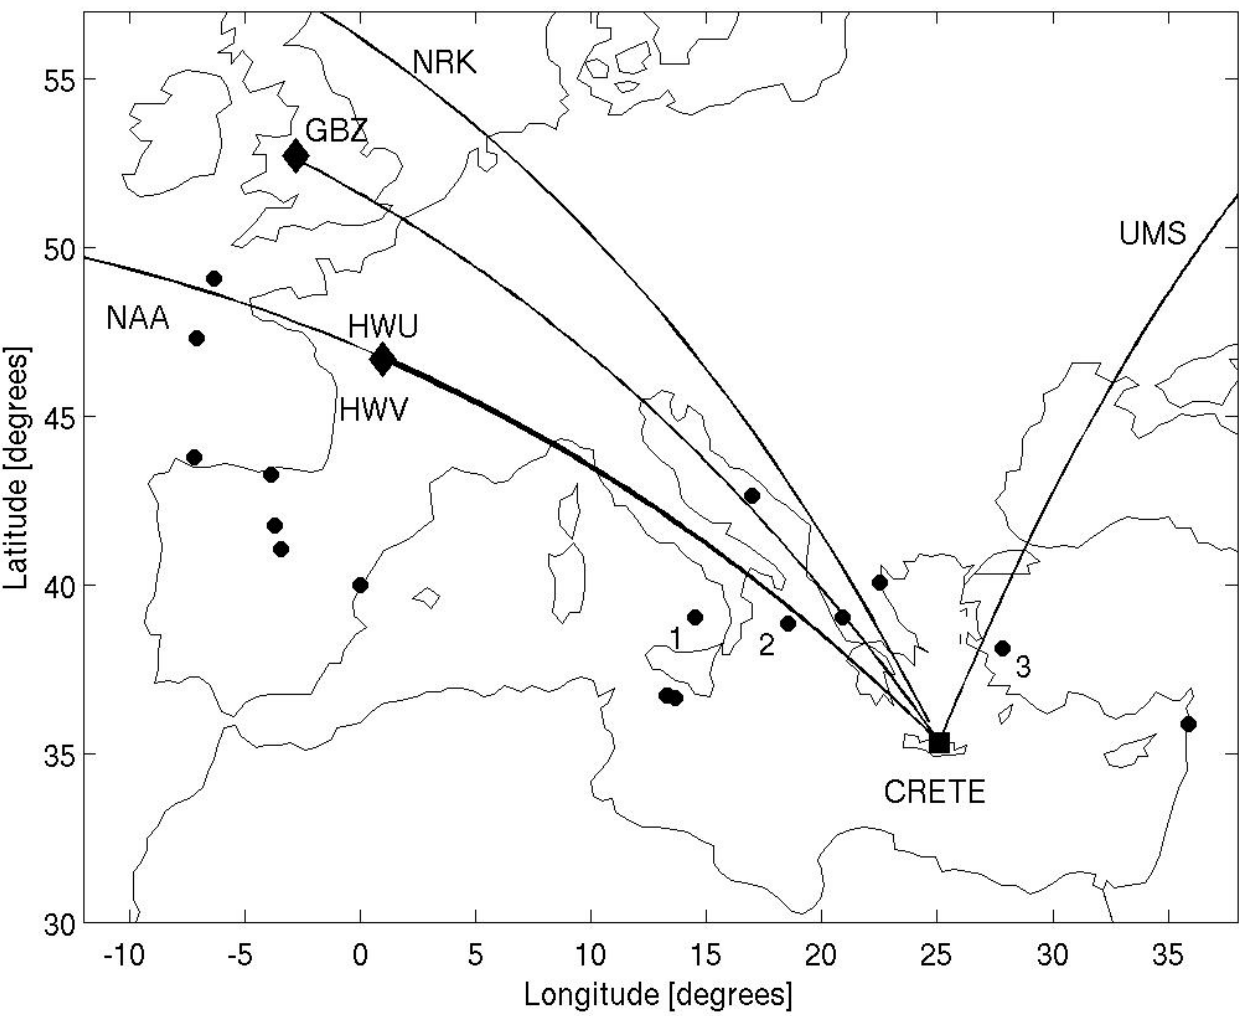
Fig. 4. Locations of the elves observed by ISUAL over Europe (circles) during the October, 2004–March, 2005 period, along with the GCPs from the VLF transmitters to the Crete receiver. The numbers mark the events accompanied by early VLF